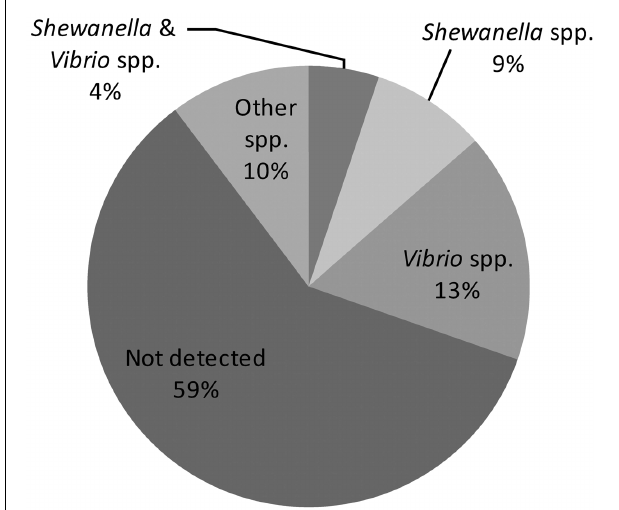
FIGURE 1 | Homology distribution of 214 “unique” genes of biotype 3 strain VVyb1(BT3) to other bacterial genes available in the GenBank database. (Detailed information about the detected homologies is presented in supplementary Table S1).